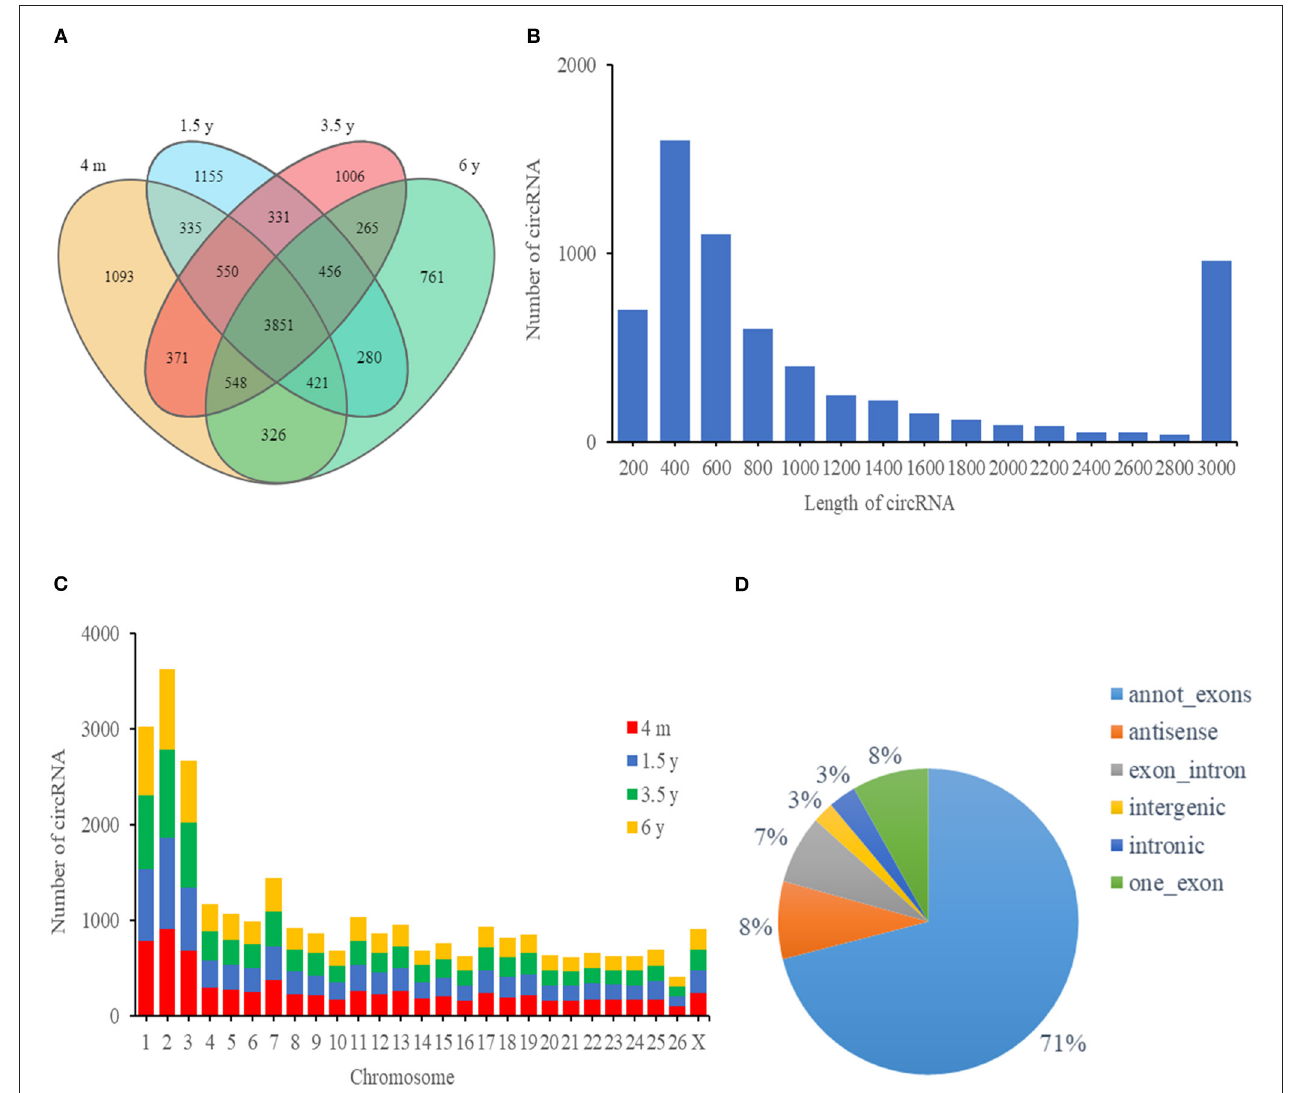
FIGURE 2 | circRNA characteristics of the LT muscle of Tibetan sheep. (A) Venn diagram showing the overlap of annotated circRNAs of Tibetan sheep among 4m, 1.5 y, 3.5 y, and 6 y. (B) The length distribution of circRNAs. (C) Chromosome distribution of circRNA in the LT muscle of Tibetan sheep. (D) The distribution of genomic regions from which circRNAs were